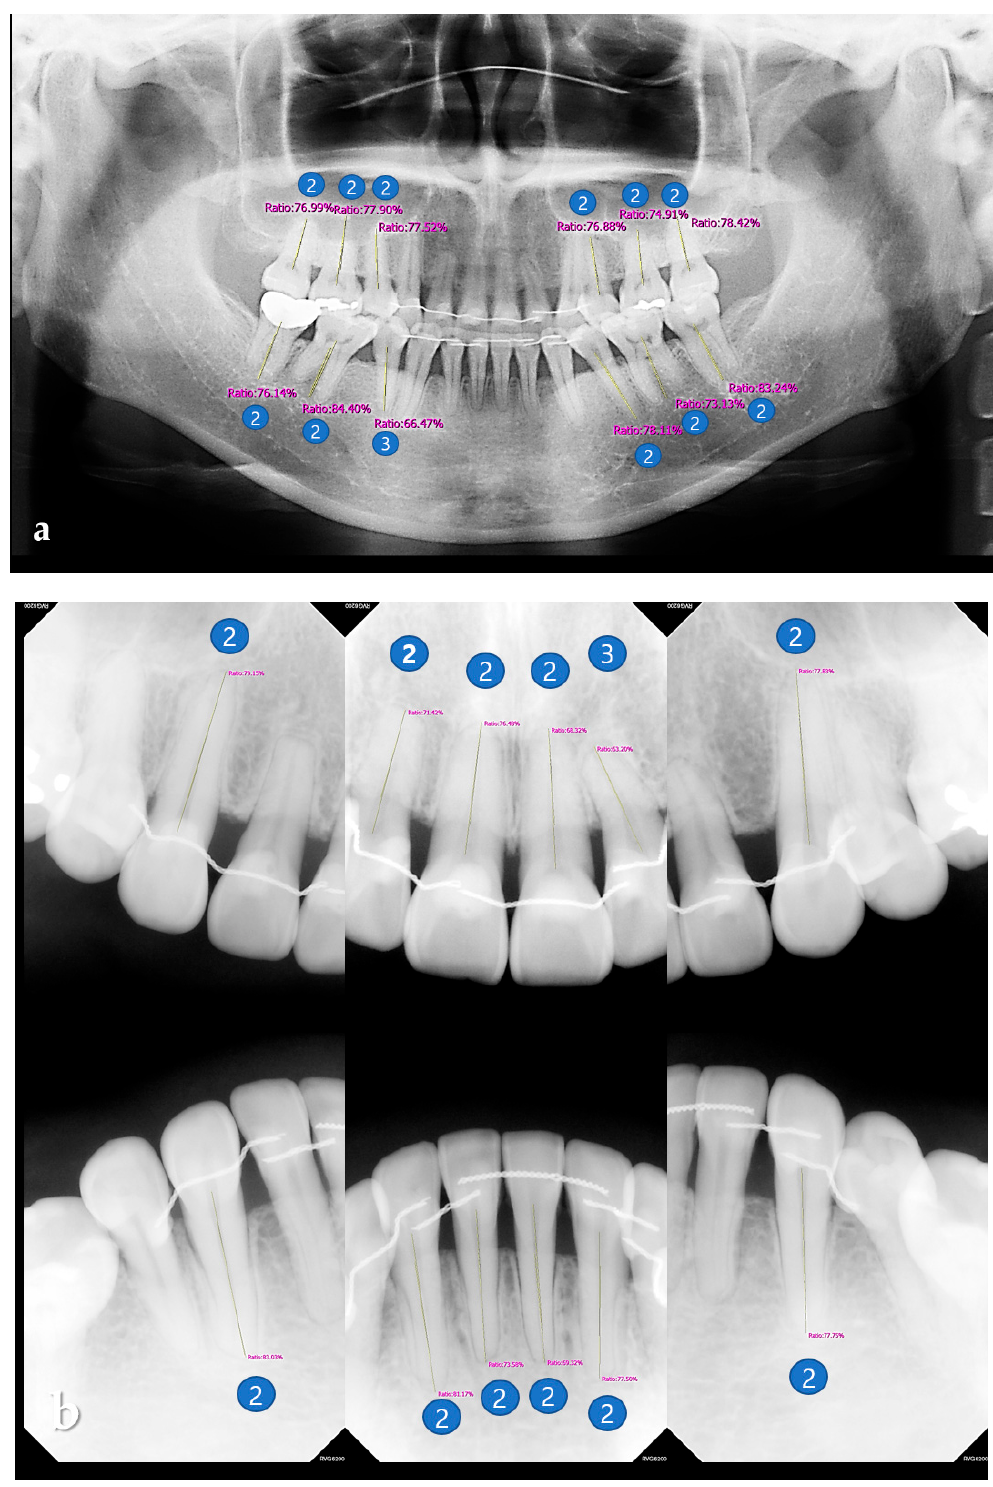
(Figure 6) [16,25]. The average of the RBL scores of the total, maxillary, mandibular, anterior, and posterior teeth were calculated.